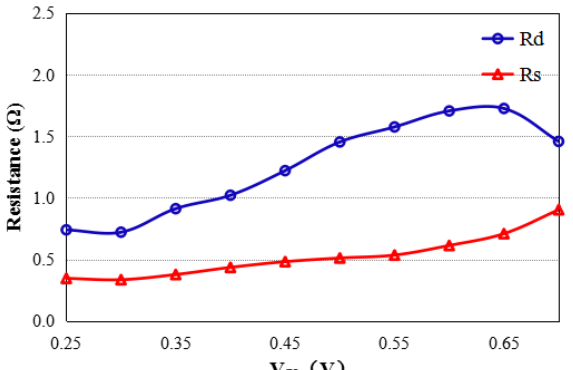
Figure 7. The extracted R d and R s against V gs , in which R d changes about 239% and R s changes about 270% with V gs from 0.25 V–0.7 V.